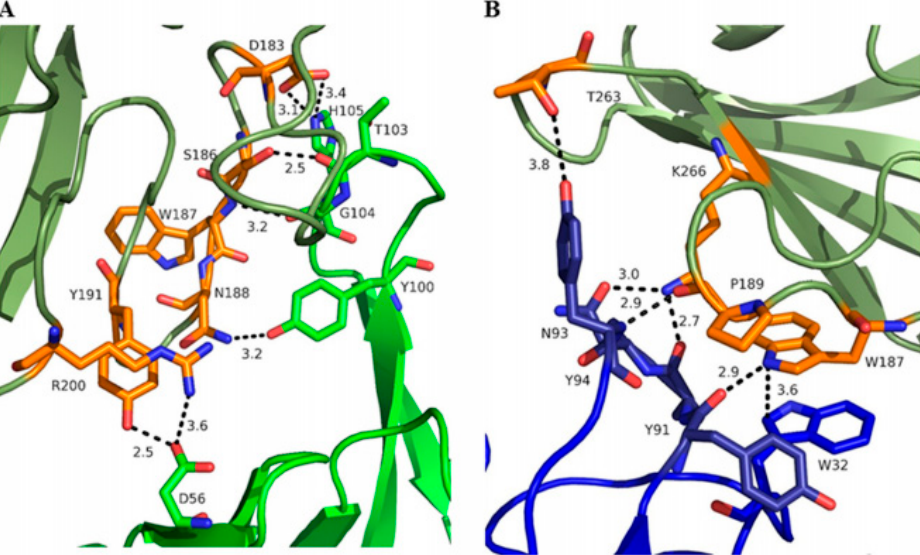
Figure 11. Interface between MEDI4893 HC (green) and AT (olive) ( A ) and MEDI4893 LC (blue) and AT (olive) ( B ). Both HC and LC are in close contact with the rim of AT and create several hydrogen bonds (dotted lines) and one stacking interaction between MEDI4893 Fab Trp32 (LC) and AT Trp187. AT residues in contact with MEDI4893 are shown in orange. Adapted from Oganesyan et al. [86].